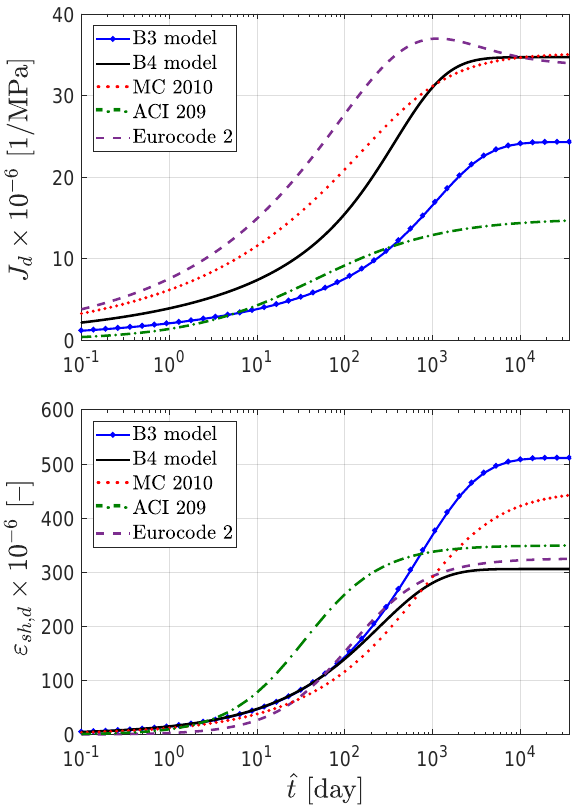
Figure 1. Drying creep compliance curves (top) and drying shrinkage curves (bottom) given by the ana- lyzed design codes and prediction models.